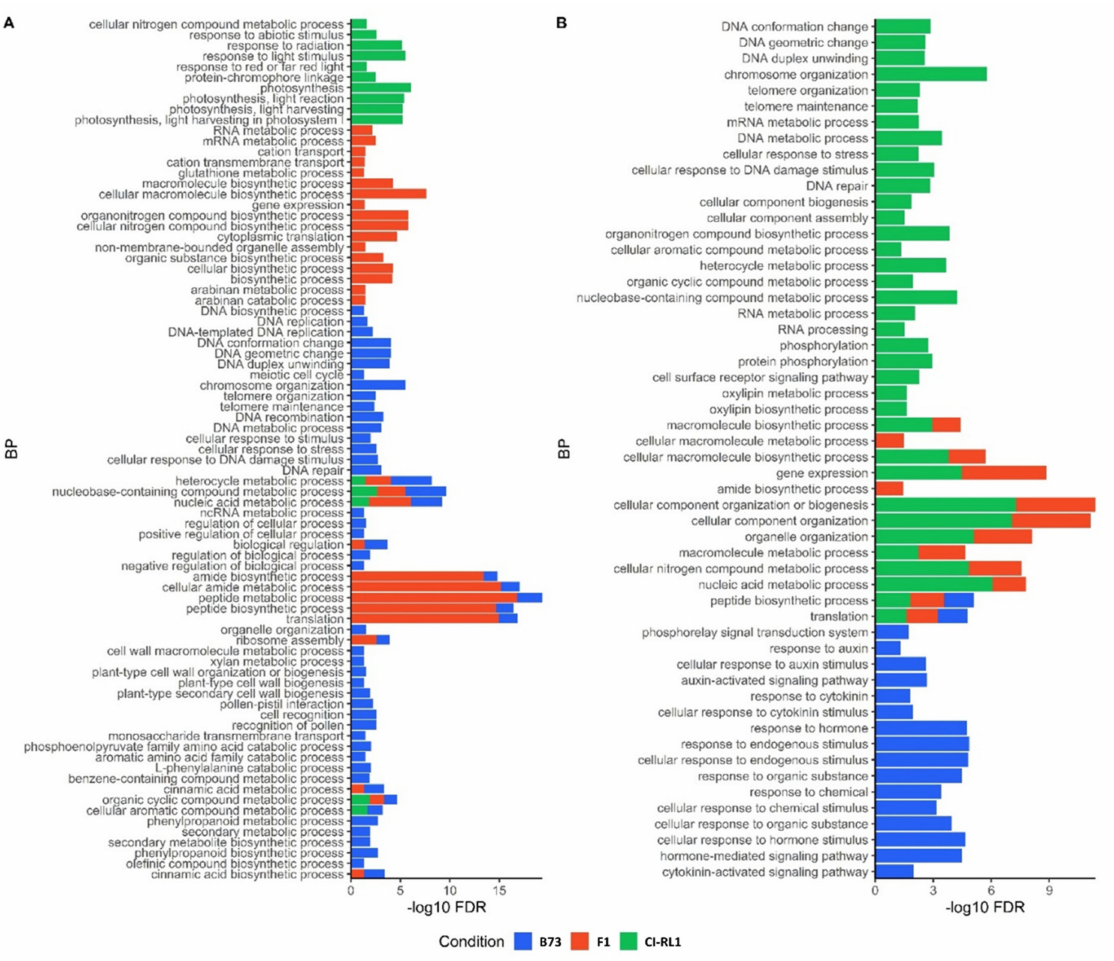
Figure 5. Bar plot of functionally up- ( A ) and downregulated ( B ) genes of the enriched biological processes (BPs) for B73 susceptible (blue), F1 progeny, (red), and CI-RL1 (in green) lines. ( A ) The x -axis represents the percentage of background annotated genes for each BP